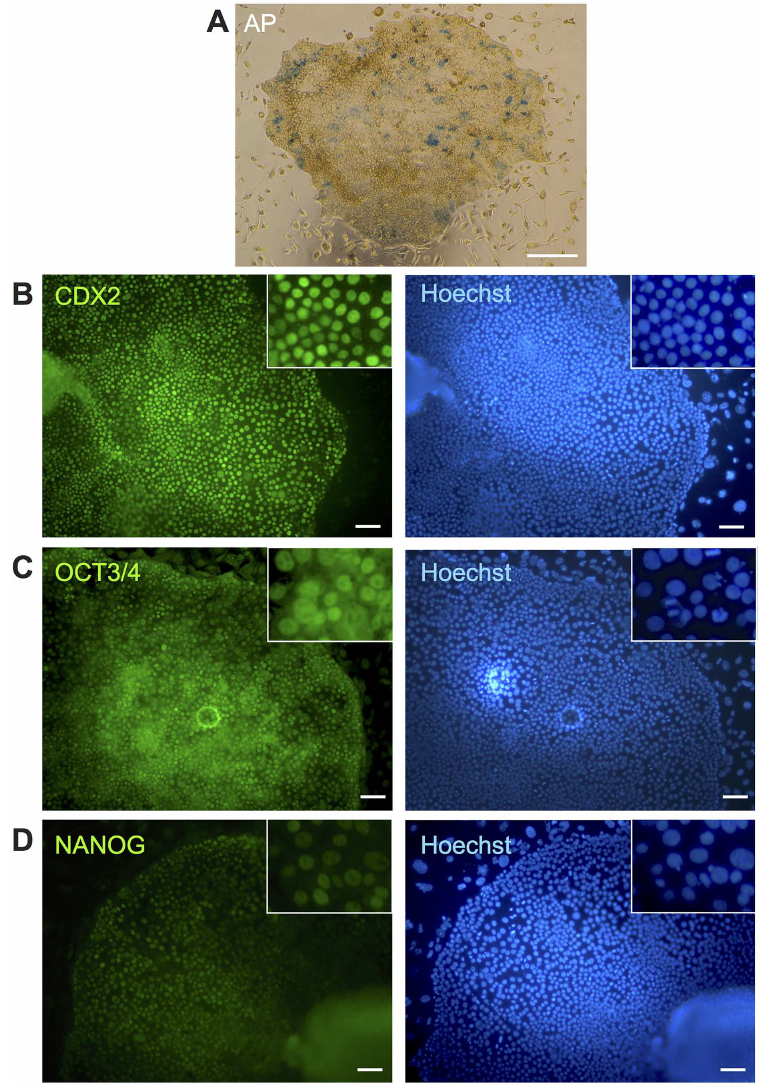
Fig 3. Characterization of bovine-induced trophoblastic cells (biTBCs). (A) Alkaline phosphatase activity in biTBCs. (B) CDX2 expressionin biTBCs. (C) OCT3/4 expressionin biTBCs. (D) NANOG expressionin biTBCs. (A) scale bars = 500 μ m. (B)-(D) scale bars = 100 μ